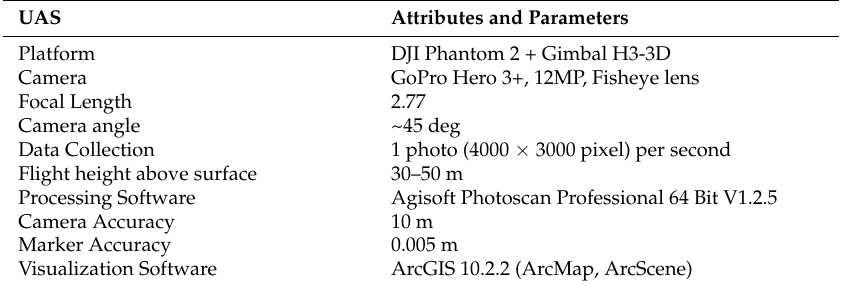
Table 1. Technical aspects, acquisition and processing parameters applied in the photogrammetric survey.